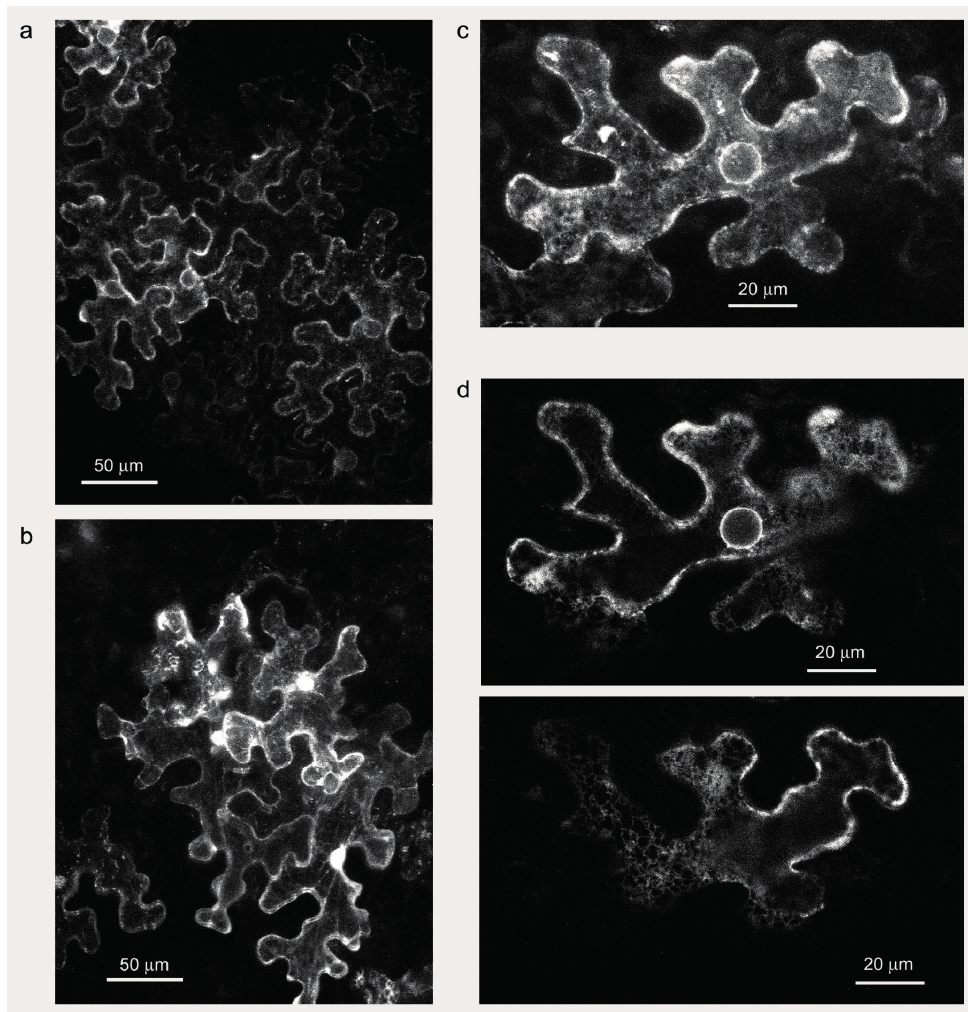
Figure 2. Arabidopsis Class I formin AtFH5 (At5g54650) can associate with the nuclear membrane and ER in the epidermis of N. benthamiana leaves after Agrobacterium-mediated transient transformation with a plasmid carrying full length AtFH5 fused to the C end of GFP under the control of the 35S promoter. ( a ) Maximum projection of a stack of confocal images of epidermal cells expressing GFP:AtFH5, 5 days post-transformation; ( b ) Control cells expressing free GFP showing cytoplasmic and nuclear localization, 6 days post-transformation (maximum projection); ( c ) Detail of a cell expressing GFP:AtFH5, 4 days post transformation (maximum projection); and ( d ) Two optical sections of the cell presented in ( c ), showing localization in the nuclear membrane ( top ) and in the sub-cortical ER ( bottom